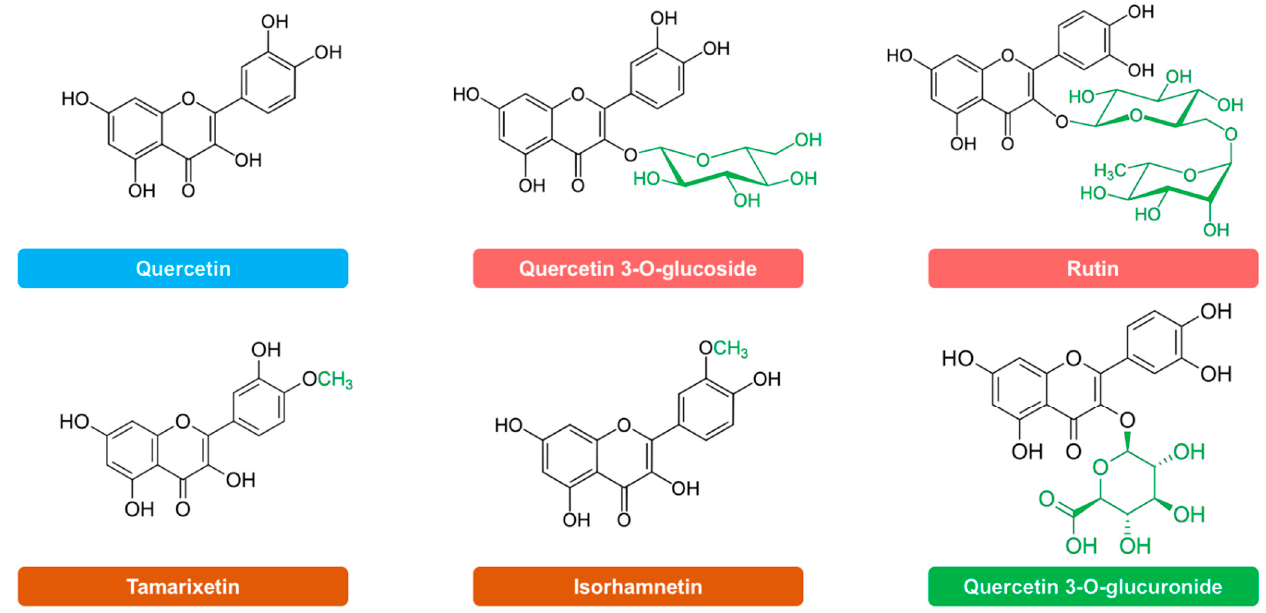
Figure 10. Chemical structure of quercetin and its metabolites used in this